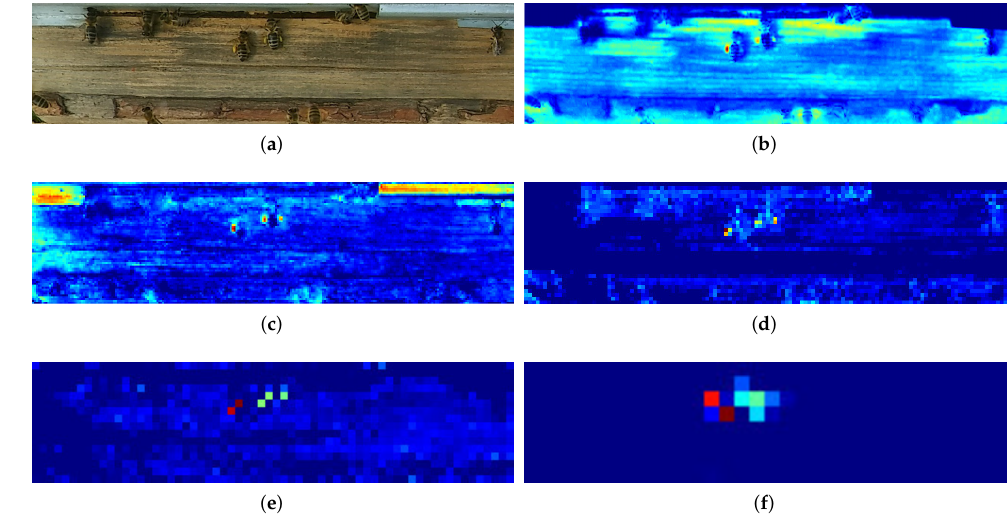
Figure 12. Image of the entrance to a hive with two bees with pollen in the centre ( a ). The 512 × 128 px feature map from the input to the 2nd convolutional layer ( b ), the 256 × 64 px feature map from the input the to 3rd convolutional layer ( c ), the 128 × 32 px feature map from the input to the 4th convolutional layer ( d ), the 64 × 16 px feature map from the input to the 5th convolutional layer ( e ), and 32 × 8 px feature map from the input to the 1st dense layer ( f